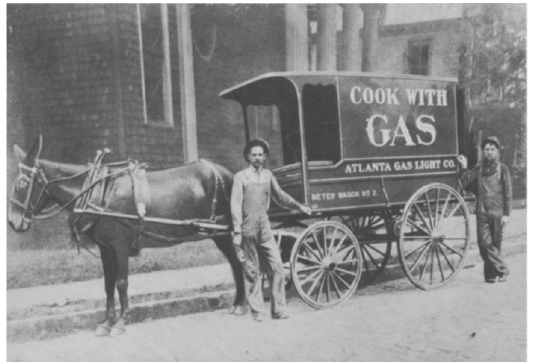
Figure 6. Advertisement for gas cooking by Atlanta Gas Light Company in the 1900s [50].